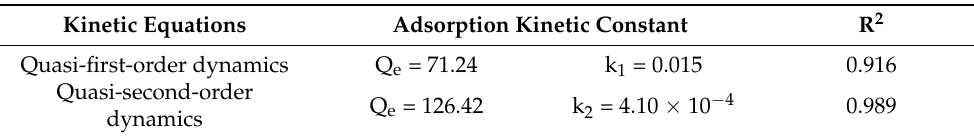
Table 1. The adsorption kinetic parameters of PMAA/GO composite hydrogel for MB. R 2 : coefficient of determination; Q e : the equilibrium adsorption capacity; k 1 : the kinetic reaction rate constant; k 2 : the adsorption rate constant obtained from the quasi-second-order kinetic